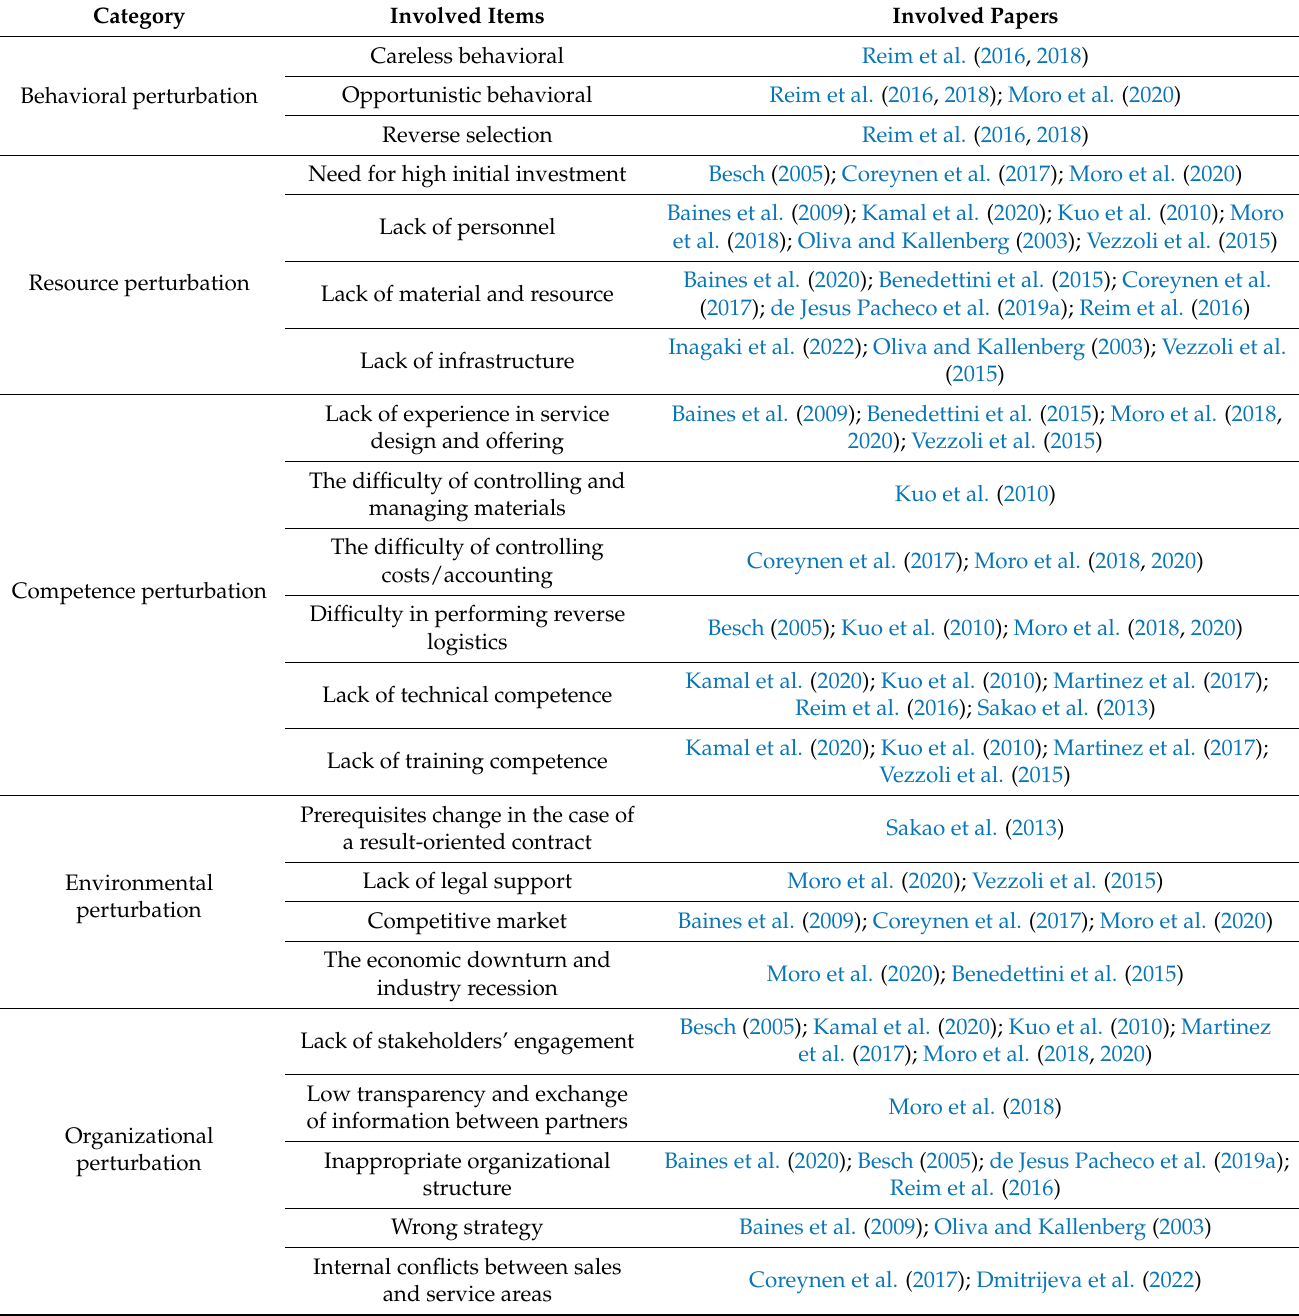
Table 2. The details of the categories and their related items of PSS